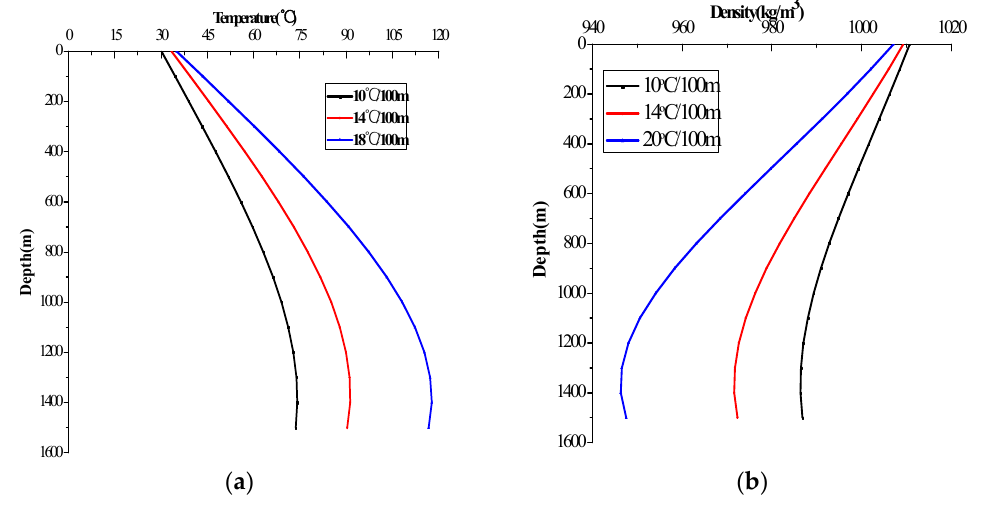
Figure 7. Temperature ( a ) and ECD ( b ) in the annulus with the geothermal gradient (circulating 8 h). Figure 8a demonstrates that the annular diameter affects the temperature distribution in the annulus. Assume that the wellbore diameter keeps constant; the diameters of the pipe are 133 mm, 159 mm and 168 mm respectively. The result indicates that the temperature in the annulus reduces as the annular diameter decreases; as the flow rate in the small annular diameter is faster than in the large annular diameter, the cooling performance enhances. The temperature in the shallow well part is little affected. The ECDs under a different annular diameter represent obvious variance in both the shallow and deep part of the well; f variation of the annular diameter causes the flow rate change, which induces the friction pressure loss in the annulus (Figure 8b).